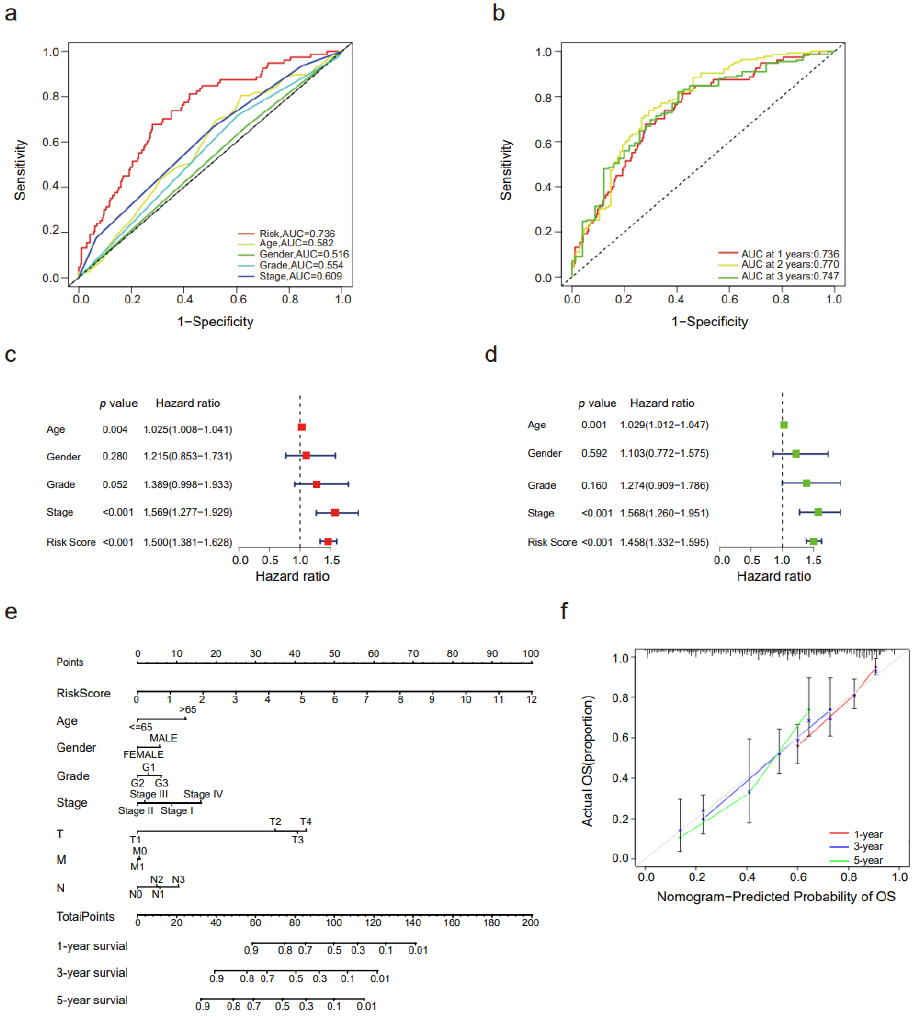
Figure 4. Forest plots and the nomogram for the prediction model constructed for STAD patients. ( a ) A ROC curve analysis of clinical features. ( b ) The time-dependent receiver operator characteristic curve (ROC) of survival analysis; the area under the ROC curve of the risk score was 0.736 at one year. The area under the ROC curve of the risk score was 0.736 at one year, 0.770 at two years, and 0.747 at three years. ( c – e ) The forest plots of univariate ( c ) and multivariate Cox ( d ) regression of the risk score and other clinical features. ( e ) The nomogram considering age, clinical stage, T stage, N stage and the risk score based on 16 prognosis-related DNA repair genes predicted the 1-year, 3- year, and 5-year survival of STAD patients. ( f ) The calibration curve for the nomogram. ROC curve analysis of the risk score at 1 year, 3 years, and 5 years.